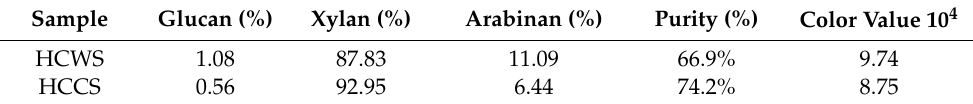
Table 8. Main chemical components of the hemicellulose fractions isolated by HAE.